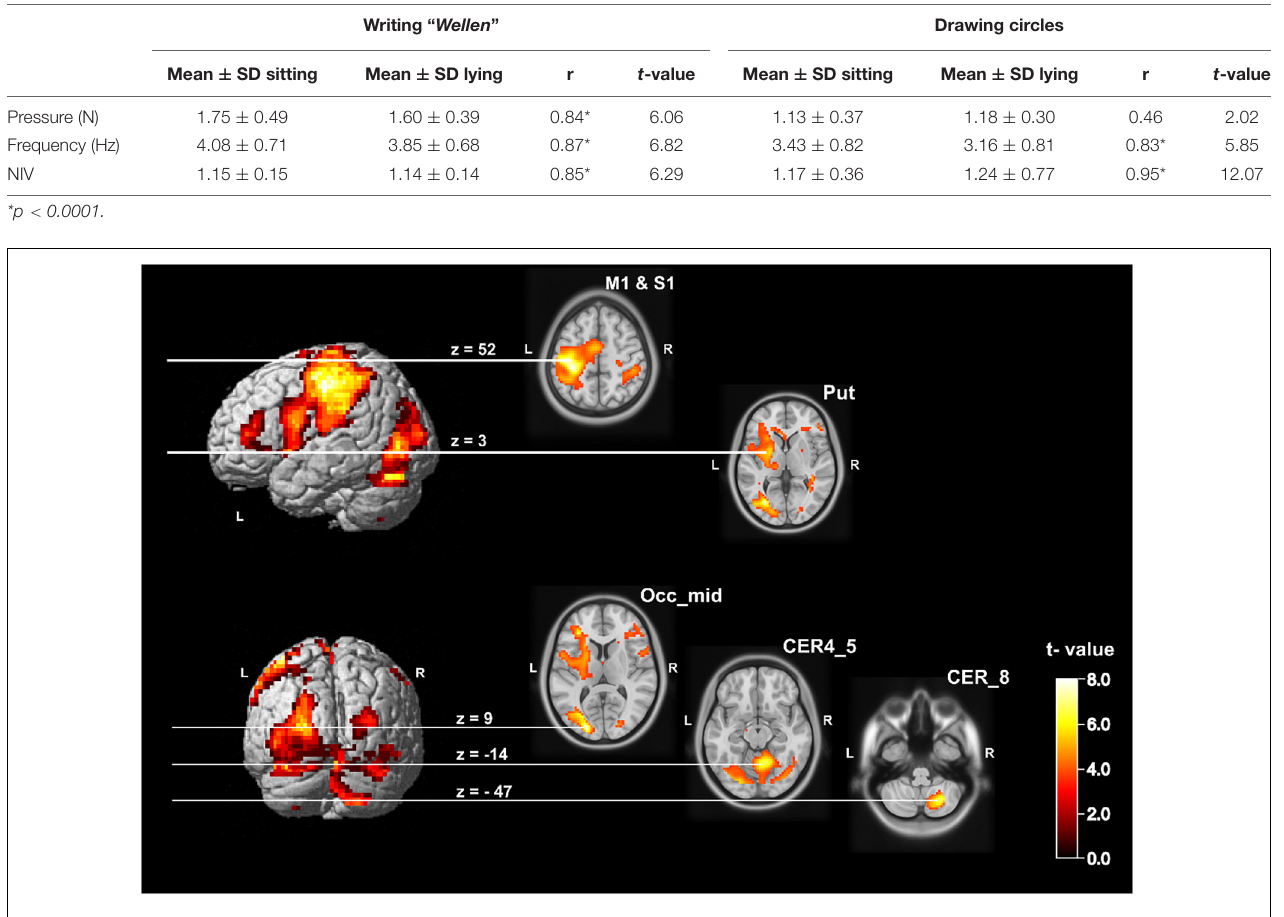
FIGURE 2 | Statistical map showing group brain activation related to the handwriting condition. It shows the five relevant clusters. On whole brain level: left postcentral gyrus with a cluster peak at [ − 33 − 31 52], middle occipital gyrus left with a cluster peak at [ − 21 − 88 9], right posterior cerebellum (Lobule VIII) with cluster peak at [27 − 64 − 47] and the right anterior cerebellum (Lobule IV and V) with a cluster peak at [9 − 55 − 14] ( p < 0.05, FWE corrected). The left putamen with a cluster peak at [ − 27 − 4 3] and the left precentral gyrus with a cluster peak at [ − 51 2 26] became significant on p < 0.05 (FWE corrected) within the ROI